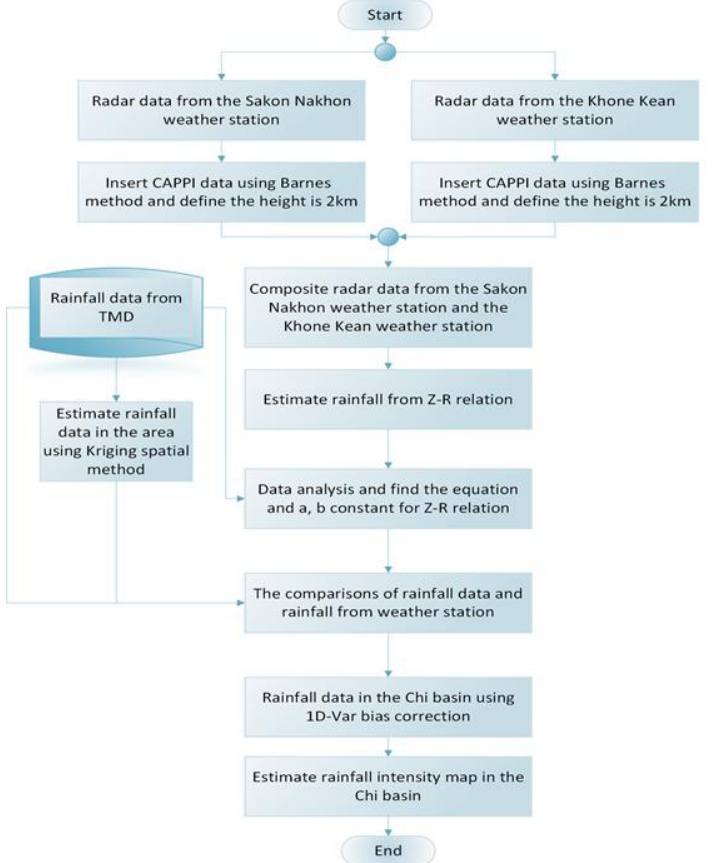
Figure 4. Flow diagram for processing and merging radar and rain gauge rainfall to create spatial rainfall map and data for the Chi Basin.